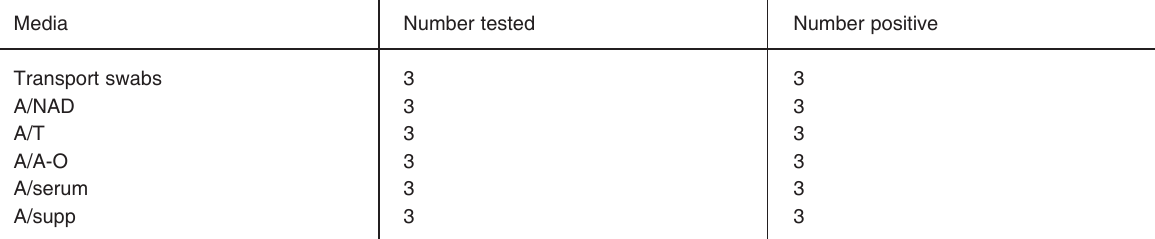
TABLE 5 Isolation of H. paragallinarum from different transport media sent to Cape Town and returned to Bloemfontein in different transport media over a period of 6